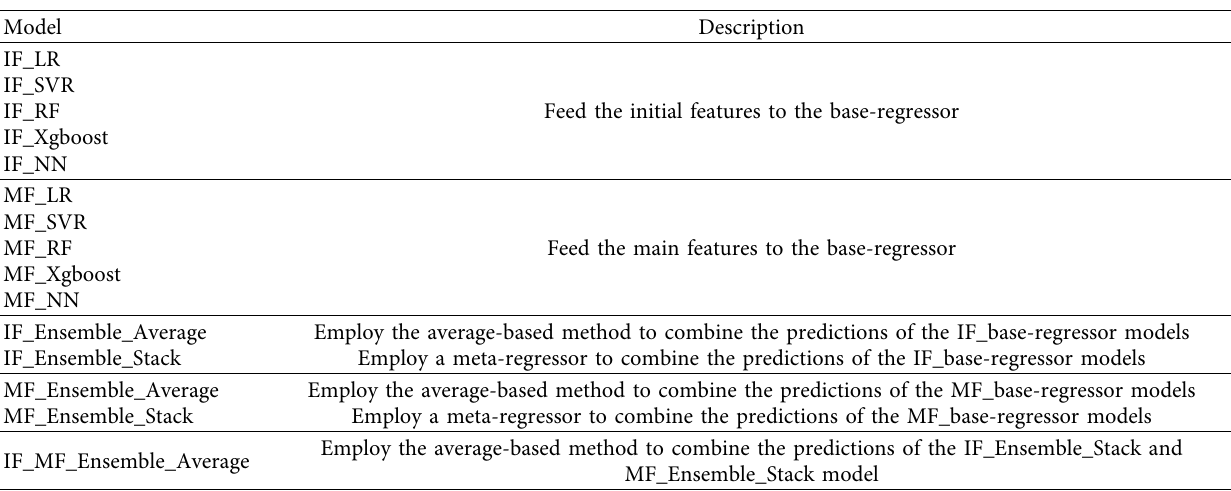
Table 3: Benchmark forecasting